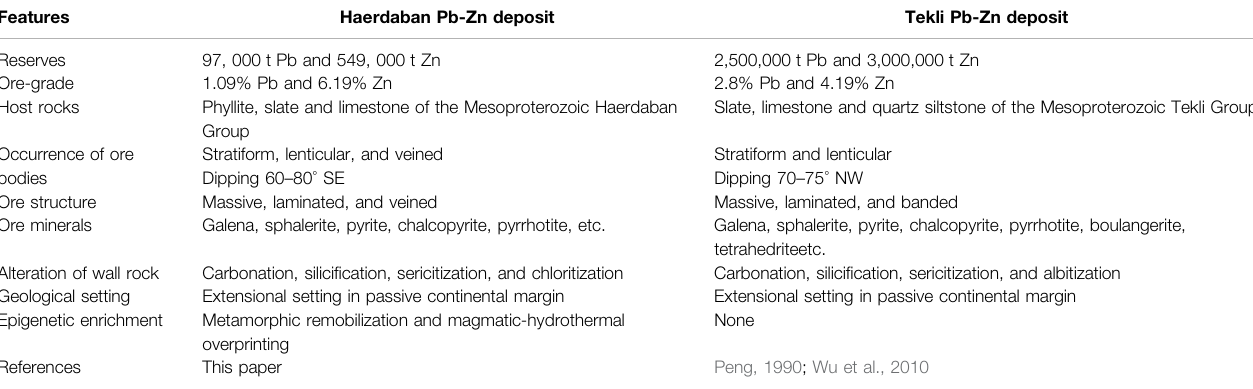
TABLE 4 | Comparison of general features of the Haerdaban and Tekli